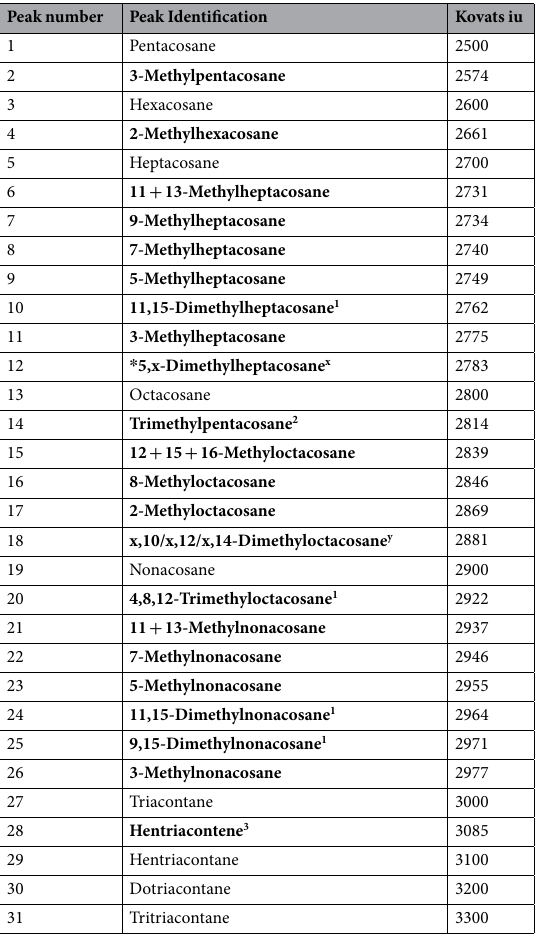
Table 3. List of all compounds extracted from the puparial case of C . vicina and the Kovats Index to aid identification. Compounds in bold were used for subsequent multivariate analysis. 1 Tentative identification based on Kovats Index. 2 Methyl branch position not determined. 3 Double bond positions only determined in adult flies. x x = 9,11, 15. y x = methyl branched position not